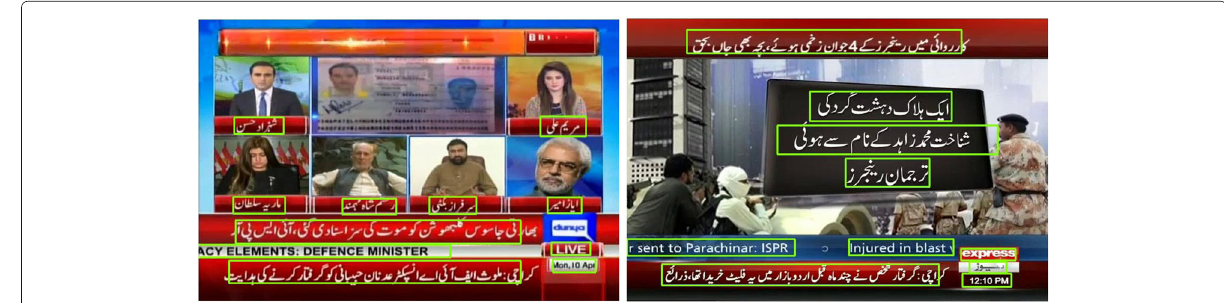
Fig. 8 Text detector output on sample video